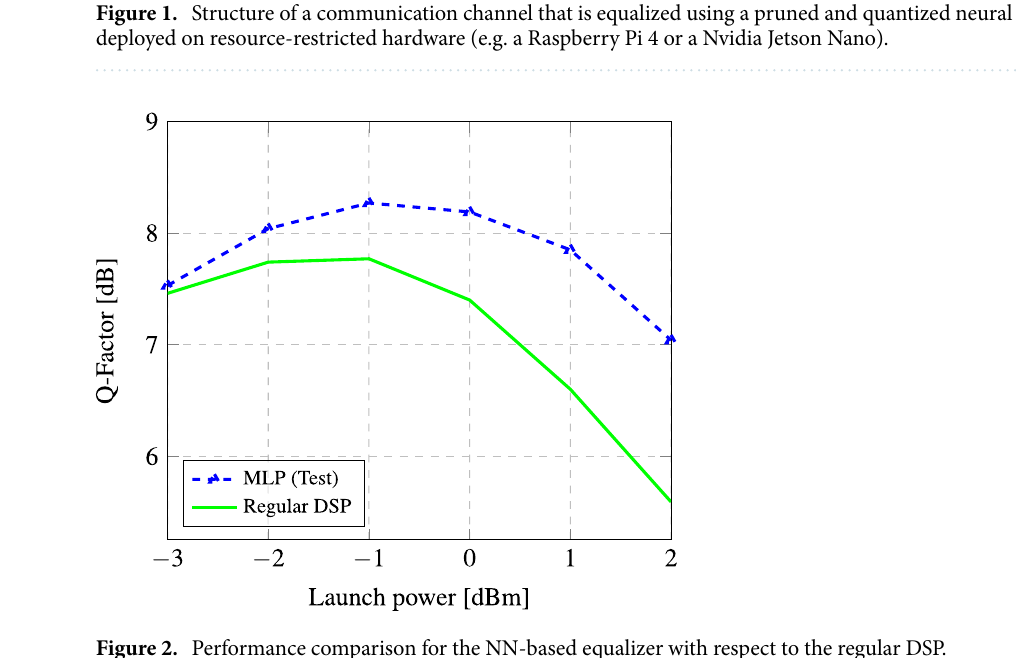
Figure 2. Performance comparison for the NN-based equalizer with respect to the regular